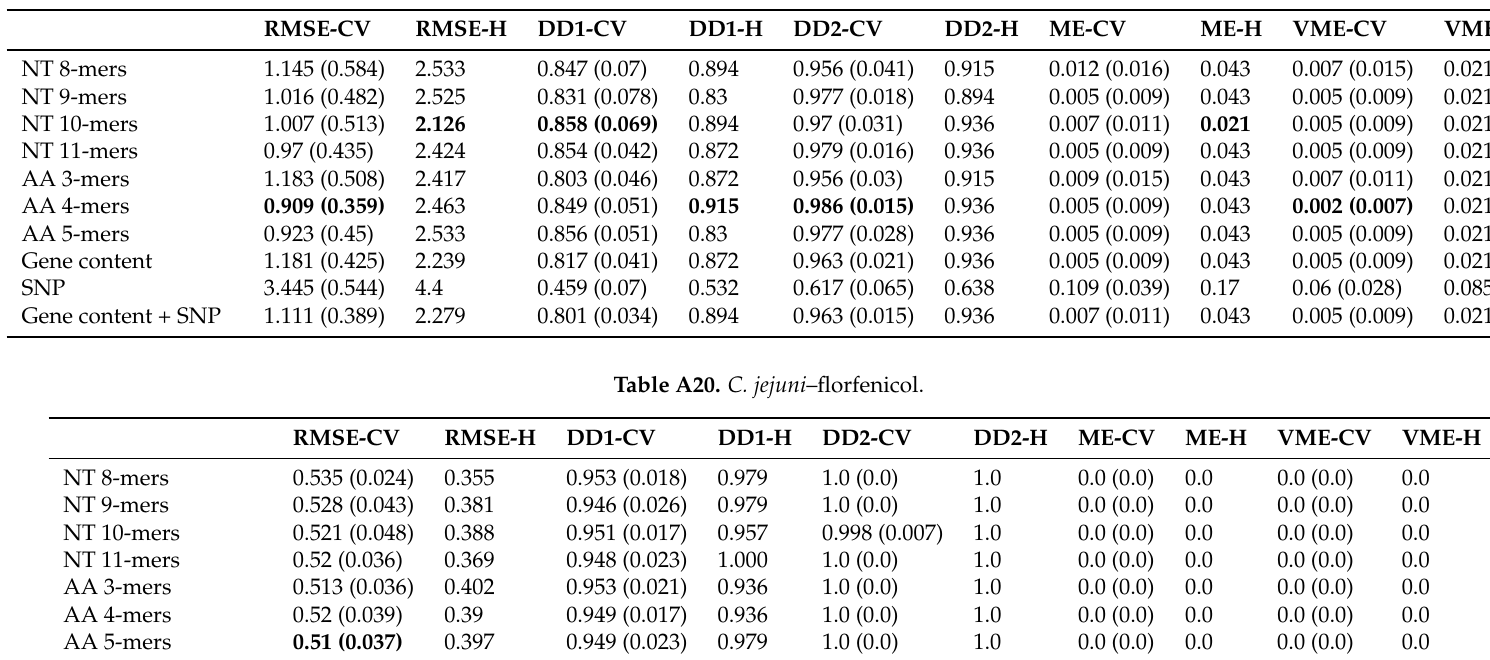
Table A19. C. jejuni –tetracycline.